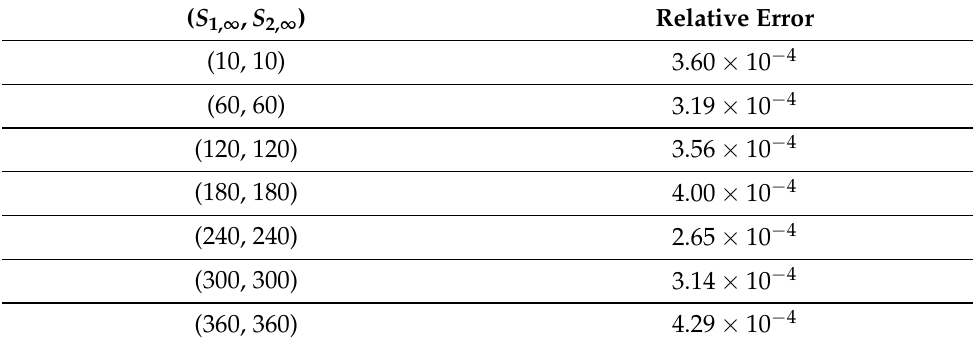
Table 3. Relative error with scaled weights.